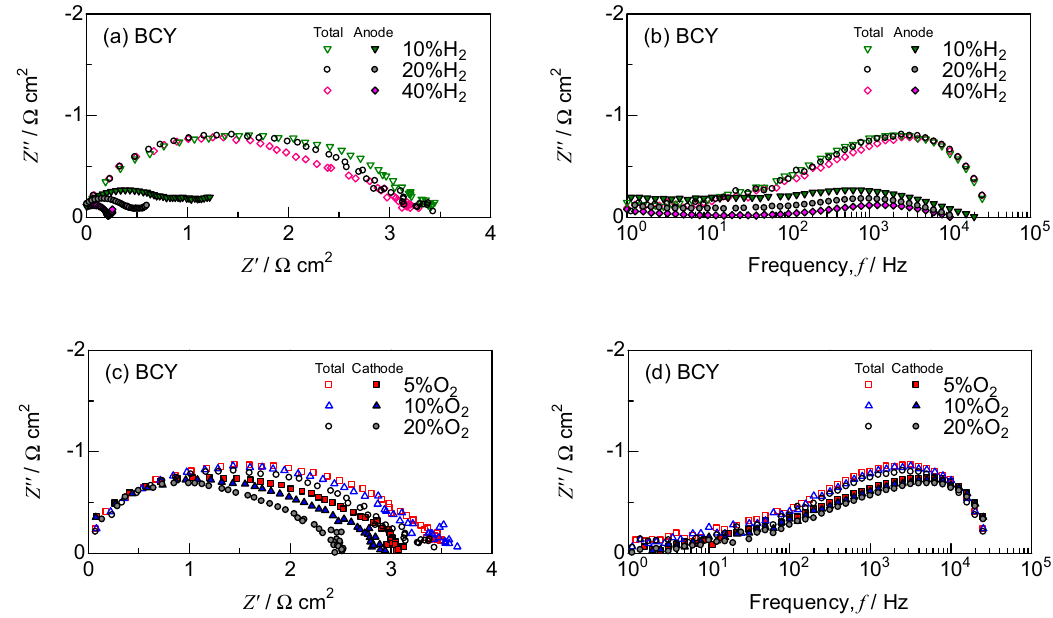
Figure 3. IR-free impedance spectra at 700 °C in ( a , b ) the constant oxidant of O 2 :H 2 O:N 2 = 20:3:77 vol.% and ( c , d ) the constant fuel of H 2 :H 2 O:N 2 = 20:3:77 vol.% for PCFCs supported on BCY electrolyte.